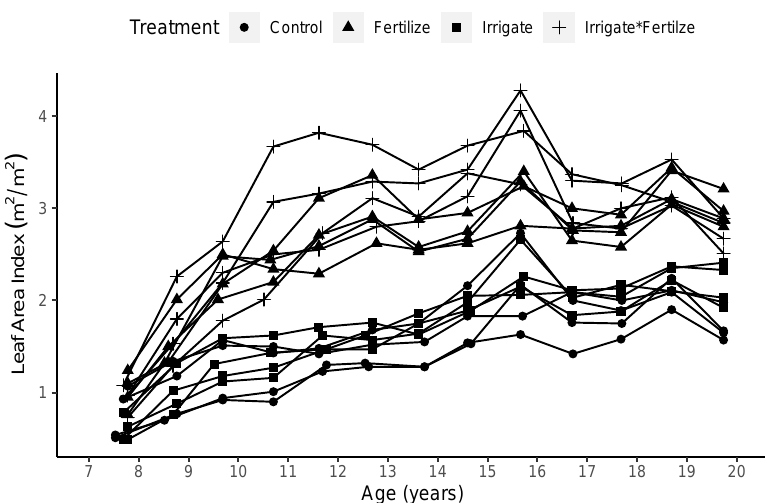
Figure 3. Peak leaf area index measurements for the sixteen Southeast Tree Research and Education Site (SETRES) plots in Scotland County, North Carolina over the study period (1992–2004). Peak leaf area index typically occurred in August or September of any given year.